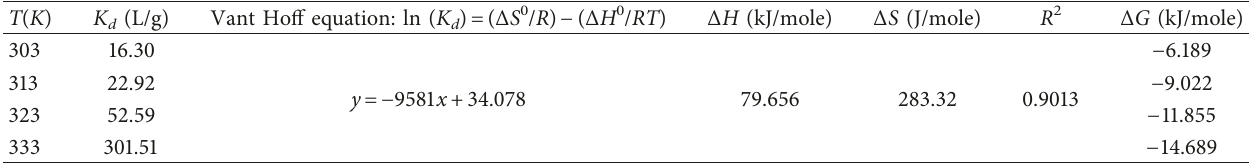
Table 2: Thermodynamic parameters of adsorption of the lead on HRMCAB.